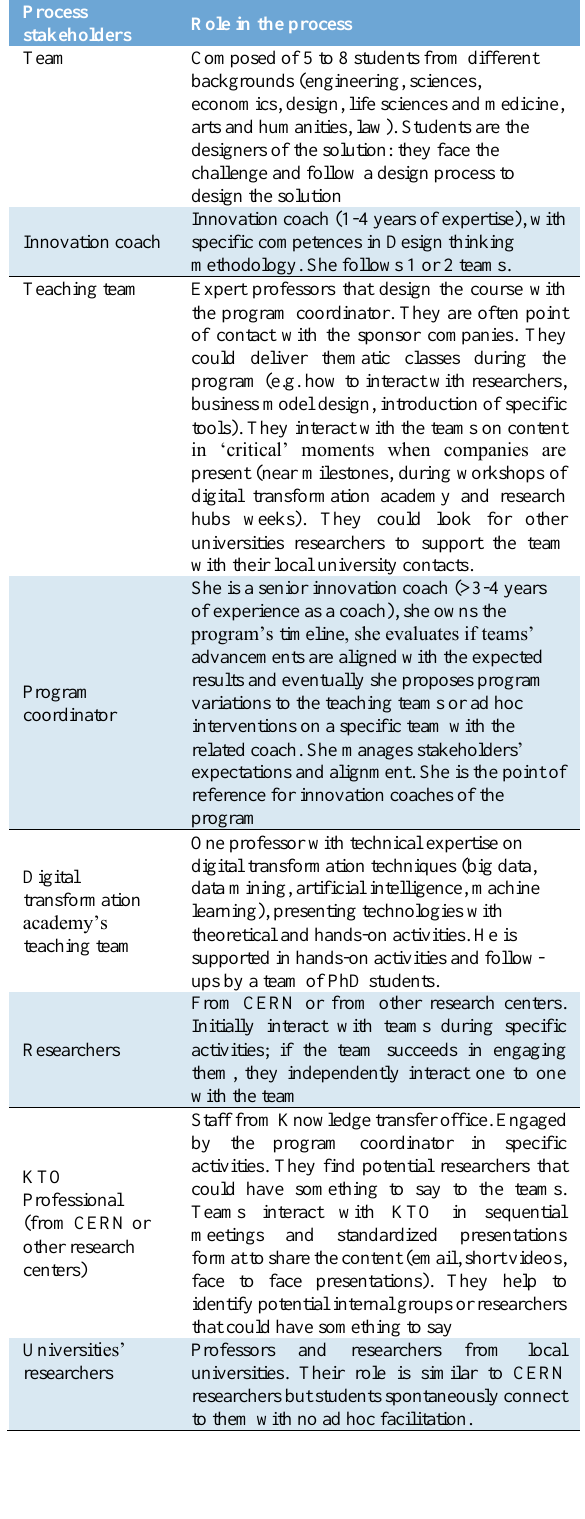
Table 1. Oper.CBI stakeholders and